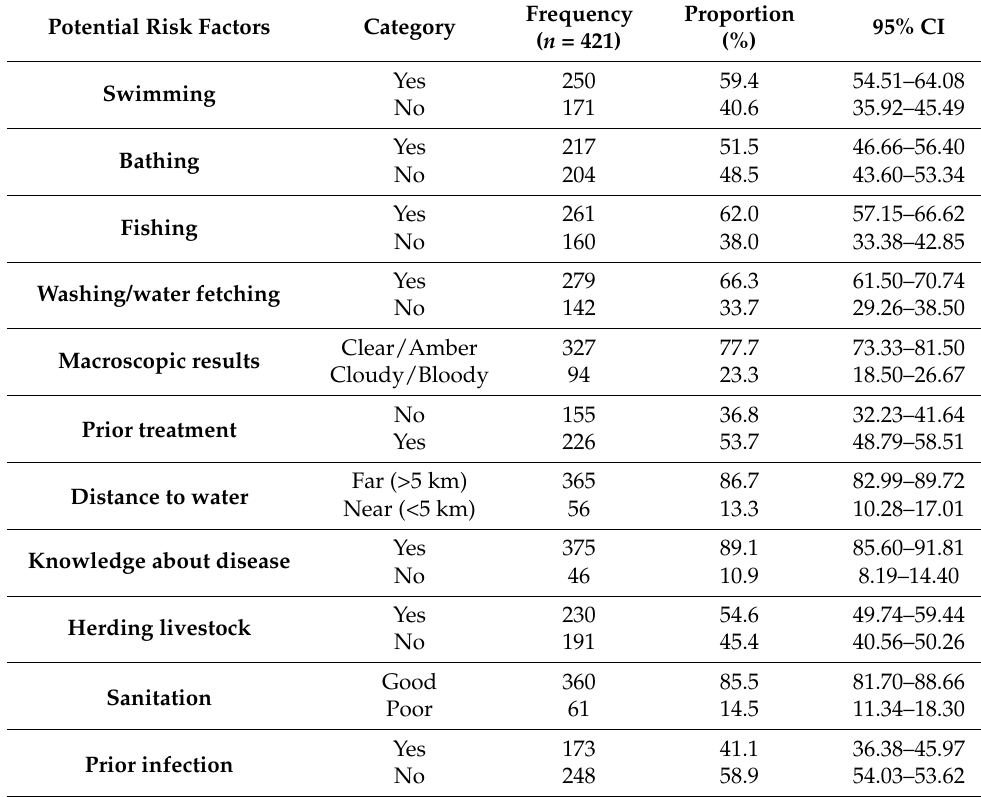
Table 4. Proportion of potential risk factors among